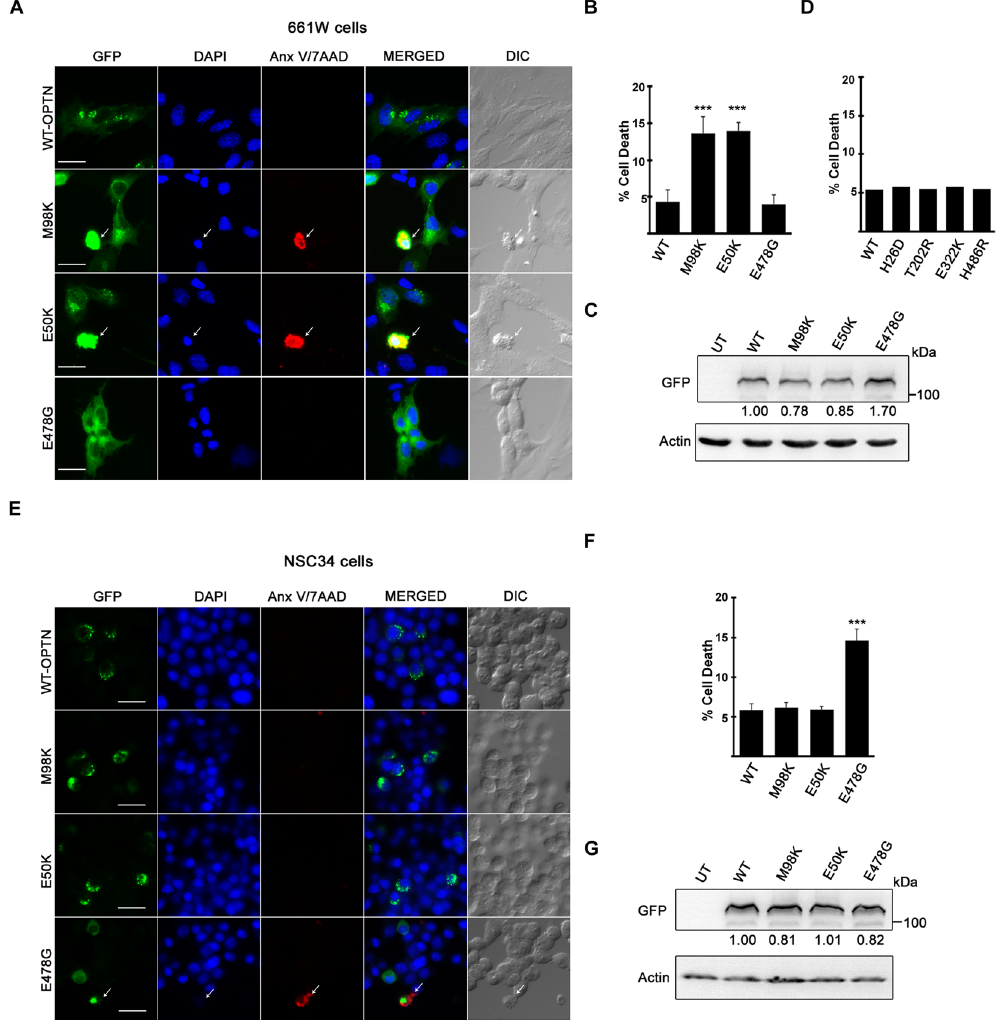
Figure 5. Effect of over-expression of OPTN and its mutants on the survival of 661W and NSC34 cells. ( A , E ) GFP tagged OPTN and its mutants were overexpressed by transfection in 661W and NSC34 cells grown on coverslips. After 32 hours of transfection, cells were stained for the detection of cell death. Panels show representative images of 661W ( A ) and NSC34 ( E ) cells expressing indicated proteins. Scale bar: 10 µ m. ( B , F ) Quantitation of cell death induced by wild type OPTN and its mutants is shown in 661W and NSC34 cells, respectively. Data represent mean ± s.d. of percentage of GFP expressing cells showing Annexin V/7-AAD (Anx.V/7-AAD) staining after subtraction of cell death in non-expressing cells from three independent experiments done in duplicate. n = 6, *** p < 0.005. ( D ) Cell death induced by WT-OPTN and other glaucoma- associated mutants of OPTN quantitated using morphological criteria. Western blots show relative expression of OPTN and its mutants in 661W ( C ) and NSC34 cells ( G ). Actin was used as loading